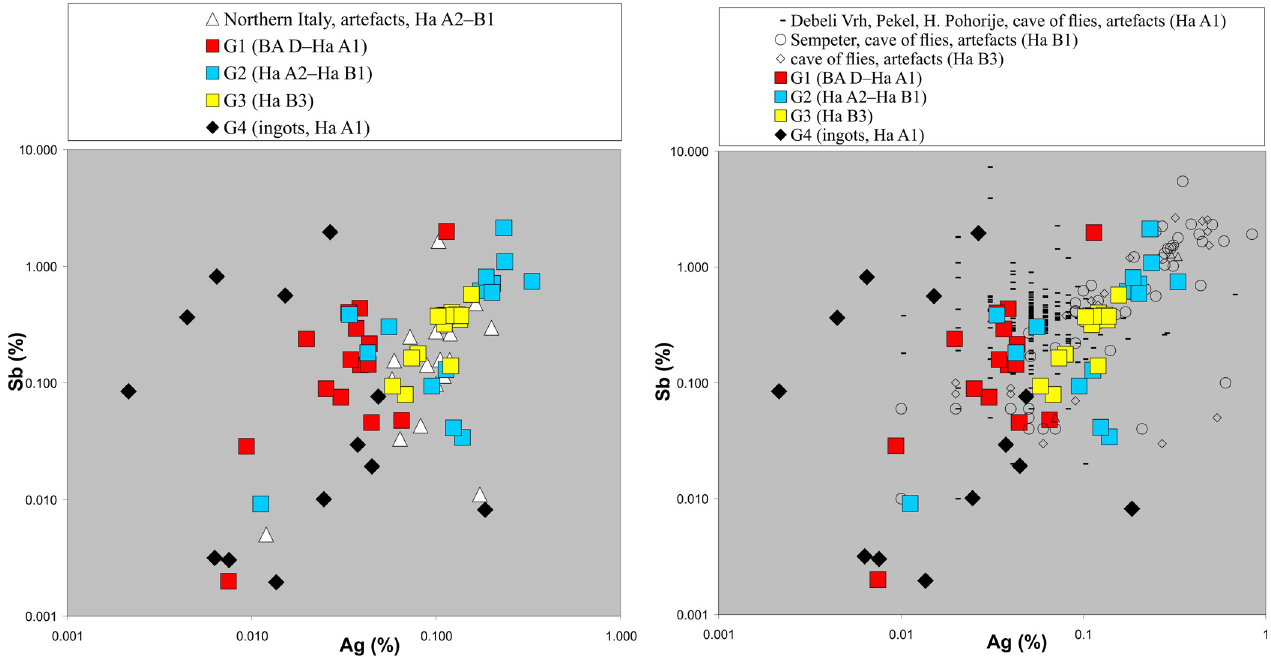
Fig 8. Comparison of the antimony-silver values of Northern Italian, Balkan and Slovenian artefacts. The left picture displays the antimony-silver concentrations found in objects from Northern Italy and the western and central Balkans subdivided by their chronology. The right presents the same combination with the Slovenian artefacts. A comparable trend–younger dated pieces have higher Sb and Ag is describable. All values are given in weight % (chart: M. Mehofer, University Vienna).